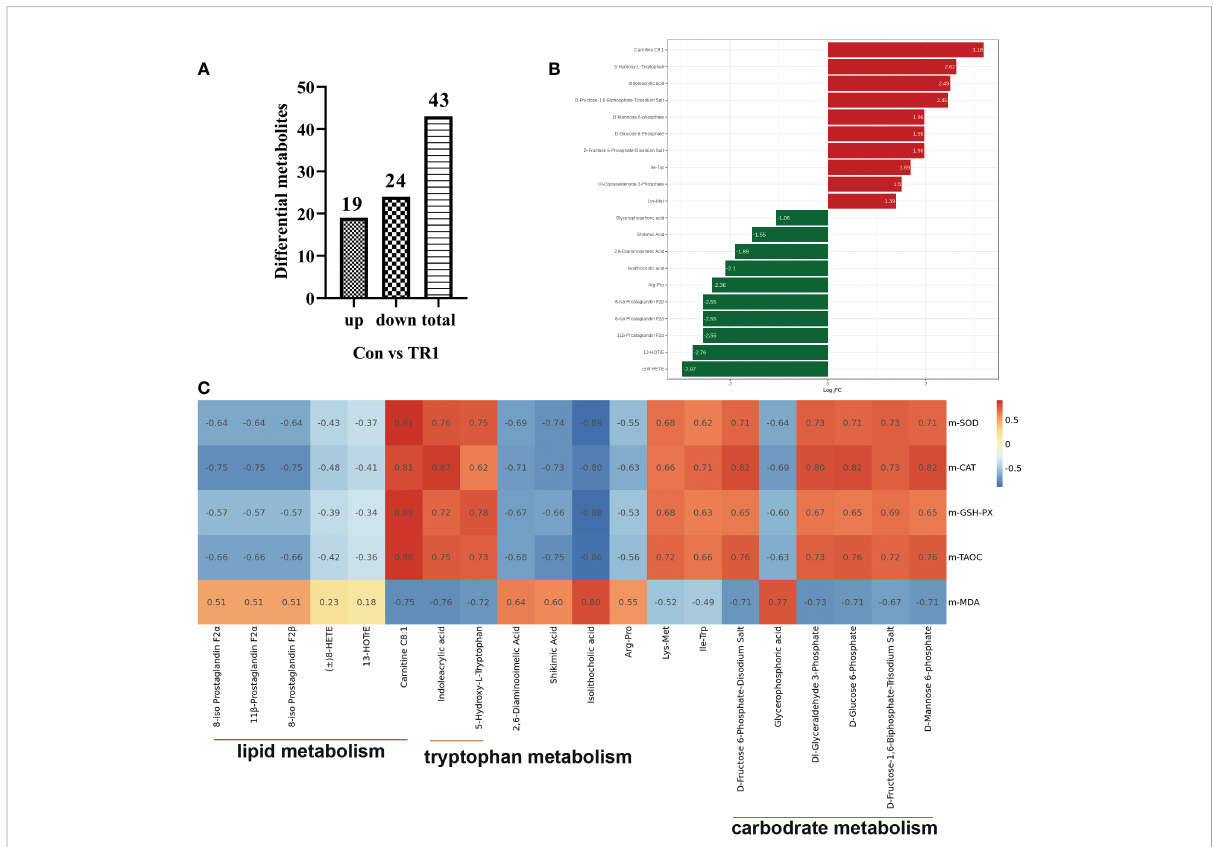
FIGURE 1 DEMs from Con vs. TR1. Upregulated, downregulated and total numbers of DEMs from Con vs. TR1 (A) , the 20 leading DEMs from Con vs. TR1 (B) , a correlation heat map between the 20 leading DEMs from Con vs. TR1 and their indexes of antioxidant performance (C)